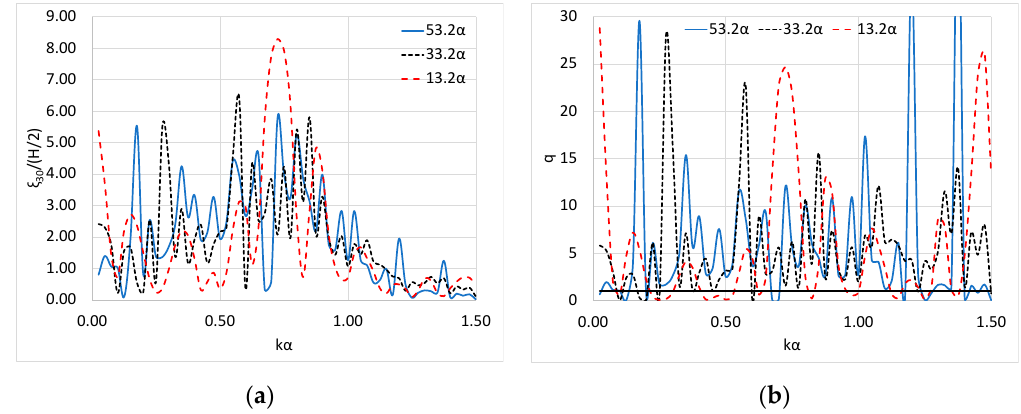
Figure 8. Effect of the V-shaped breakwater on the WEC’s (wave energy converter) performance for various examined WEC’s (wave energy converter) distances from the breakwater: ( a ) WEC’s (wave energy converter) heave motions; ( b ) q factor term. The horizontal solid line corresponds to unity.